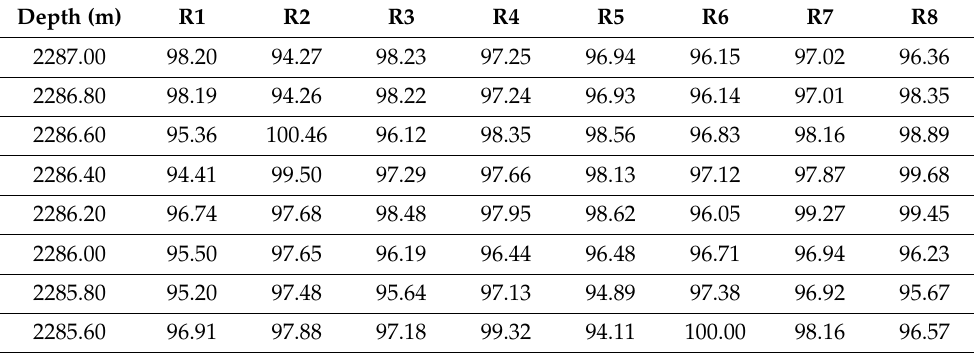
a comparison table between OpenGL and Vulcan [19,20]. A comparison of OpenGL and Vulcan is shown in Table 2. Table 2. Data in a text